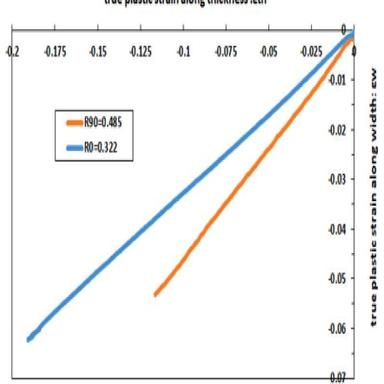
width-to-thickness plastic strain plot for (UTT) and (RHTT) to determine the Lankford coefficient.